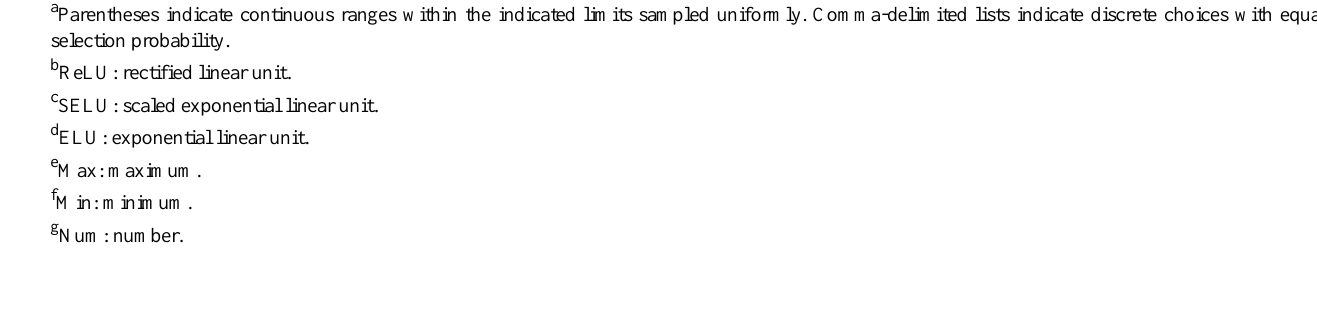
a Parentheses indicate continuous ranges within the indicated limits sampled uniformly. Comma-delimited lists indicate discrete choices with equal selection probability. b ReLU: rectified linear